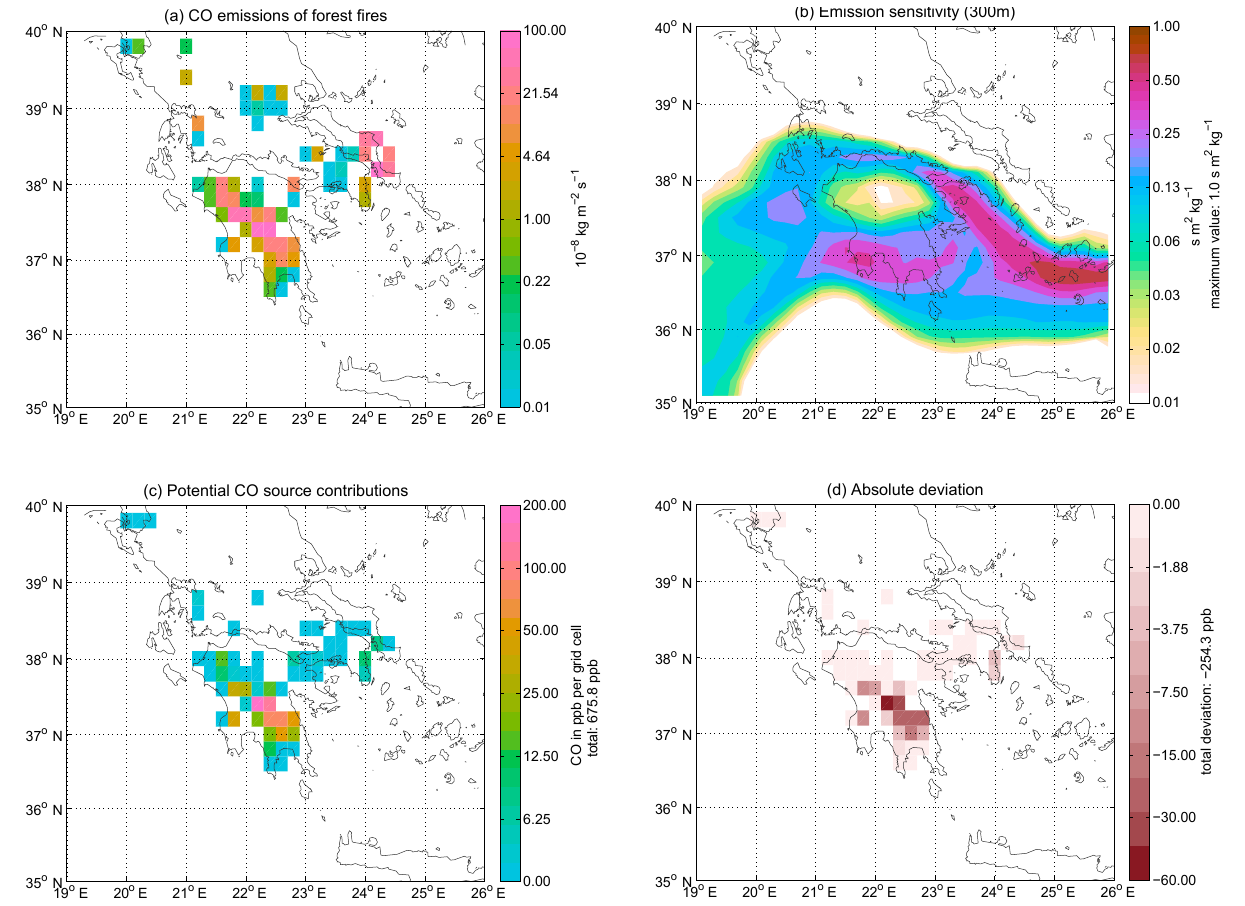
Figure 6. (a) CO emissions for forest fires in Greece on 26 August 2007 provided by GFASv1.2 (Kaiser et al., 2012) and aggregated on a grid of 0 . 2 ◦ . (b) Time-integrated emission sensitivity of a 5-day backward simulation from 30 July 2014, 15:00UTC (03:00LT), started at Cyprus and based on the 300m footprint layer height. (c) CO source contributions of forest fires to mass mixing ratio at Cyprus assuming a 300m footprint layer height and (d) absolute differences introduced by using variable fire plume heights as footprint layer height.